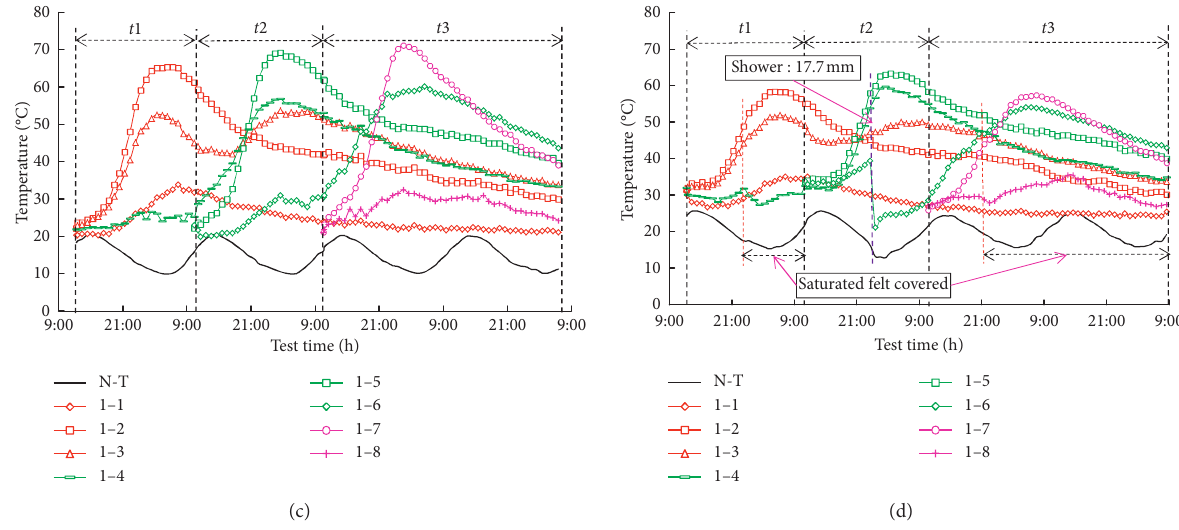
Figure 16: Relationship between temperatures and casting time: (a) project 1, (b) project 2, (c) project 3, and (d) project 4.